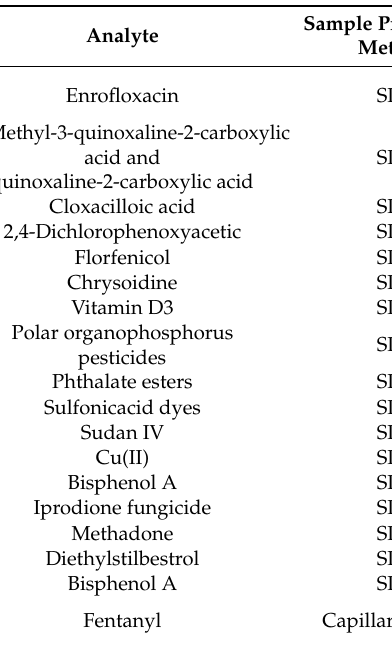
Table 1. MSG application in di ff enert sample prepartion